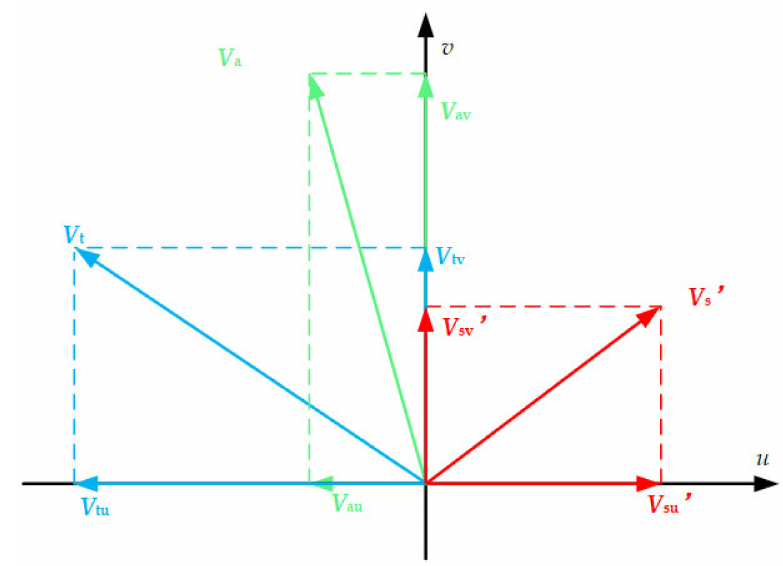
Figure 6. Calculation method of relative wind